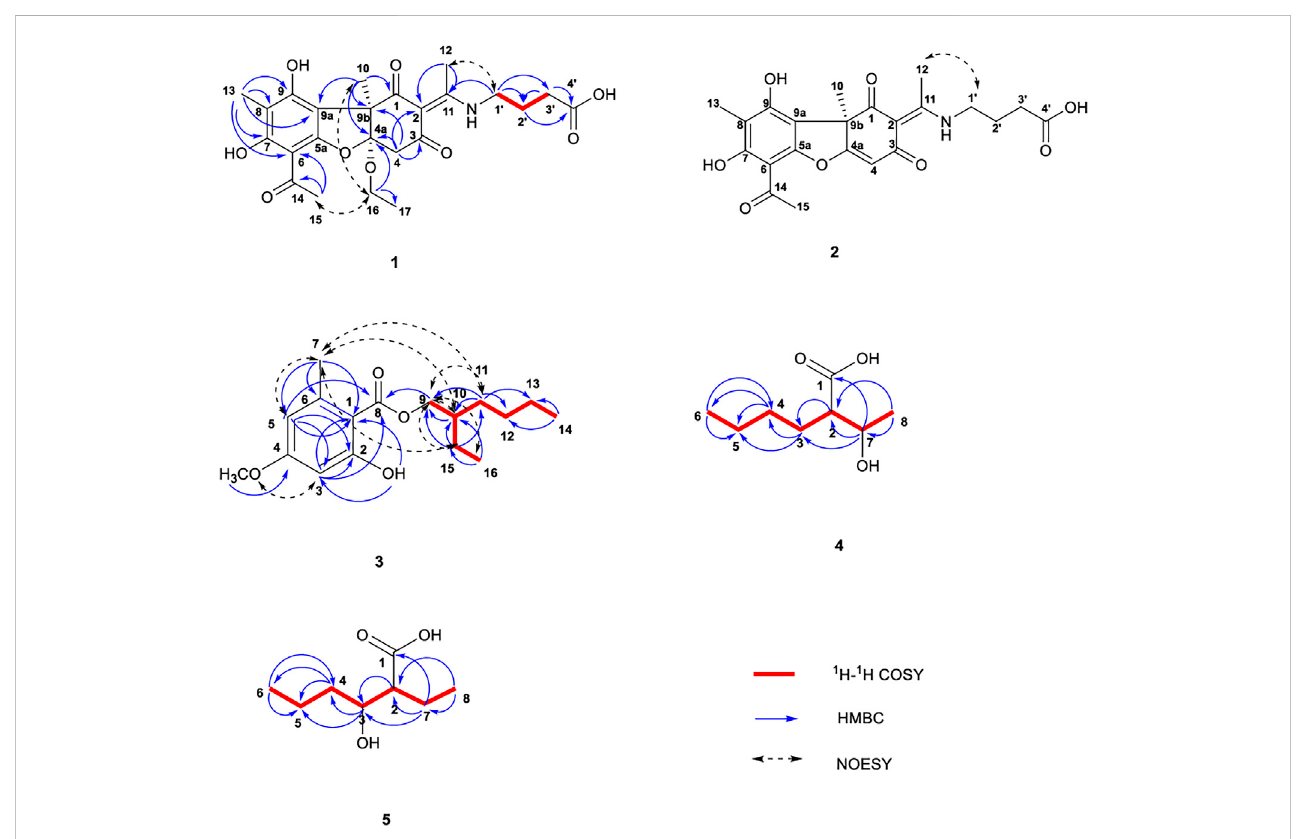
Chemical structures of compounds 1 – 5 along with the key 1 H- 1 H COSY, HMBC, and NOESY